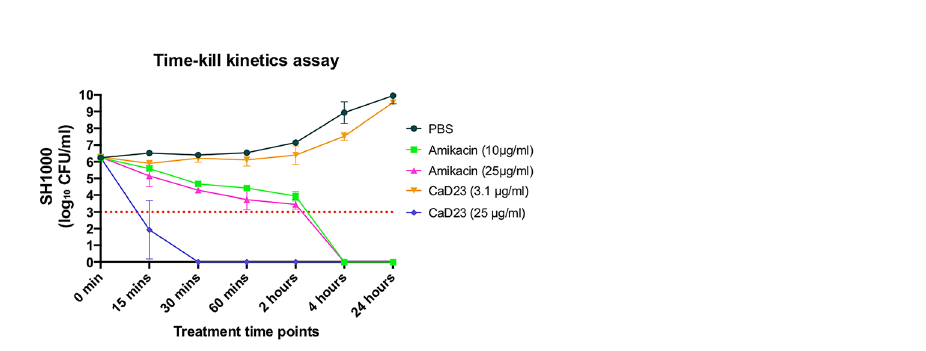
Figure 3. Time-kill kinetics of CaD23 (0.25× MIC and 2× MIC) amikacin (8× and 20× MIC) against S. aureus (SH1000) in cation-adjusted Muller-Hinton broth over 24 h. Phosphate buffer solution (PBS) group serves as the untreated control. “0 min” represents the starting inoculum, which is around 6 log 10 CFU/ml. The red dotted horizontal line at 3 log 10 CFU/ml signifies the threshold of significant bacterial killing (defined as 99.9% or 3 log 10 CFU/ml reduction of the bacterial viability compared to the starting inoculum). Data is presented as mean ± standard deviation (depicted in error bars) of two independent experiments performed in biological duplicate. CaD23 (2× MIC) was able to achieve complete (100%) killing of SH1000 within 30 min of treatment whereas amikacin (8× MIC and 25× MIC) was only able to achieve complete killing of SH1000 within 4 h of treatment. The antimicrobial efficacy of CaD23 and amikacin was maintained at 24 h